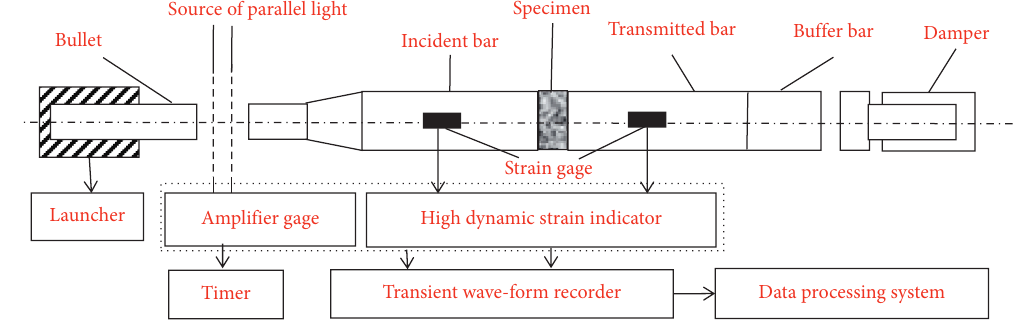
Figure 1: Schematic of SHPB experimental apparatus. Table 1: Physical performance index of Mu Us desert sand.